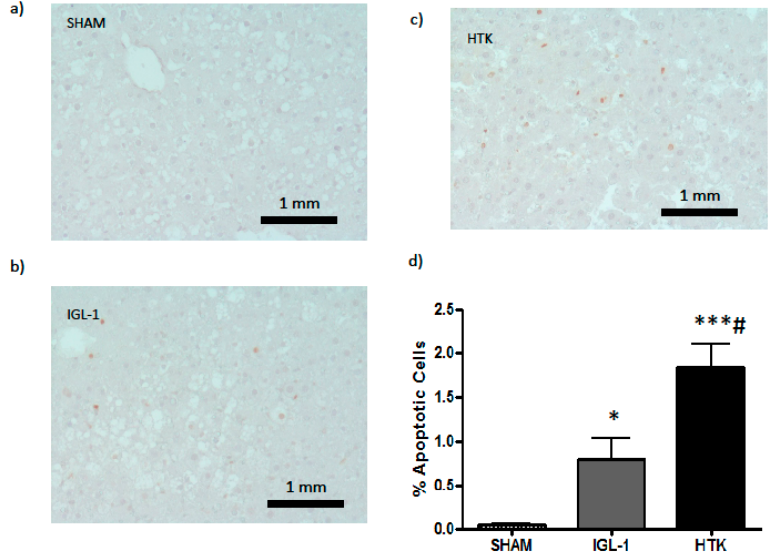
Figure 6. Apoptotic hepatic cells detected with TUNEL assay. ( a ) SHAM, ( b ) IGL-1, and ( c ) HTK. ( d ) Apoptotic cells (stained with red) were counted and damage was assessed as a percentage of positive cells for each group. Bar graphs represent the mean ± SD. * p < 0.05 vs. SHAM, *** p < 0.0005 vs. SHAM, # p < 0.05 vs. IGL-1.